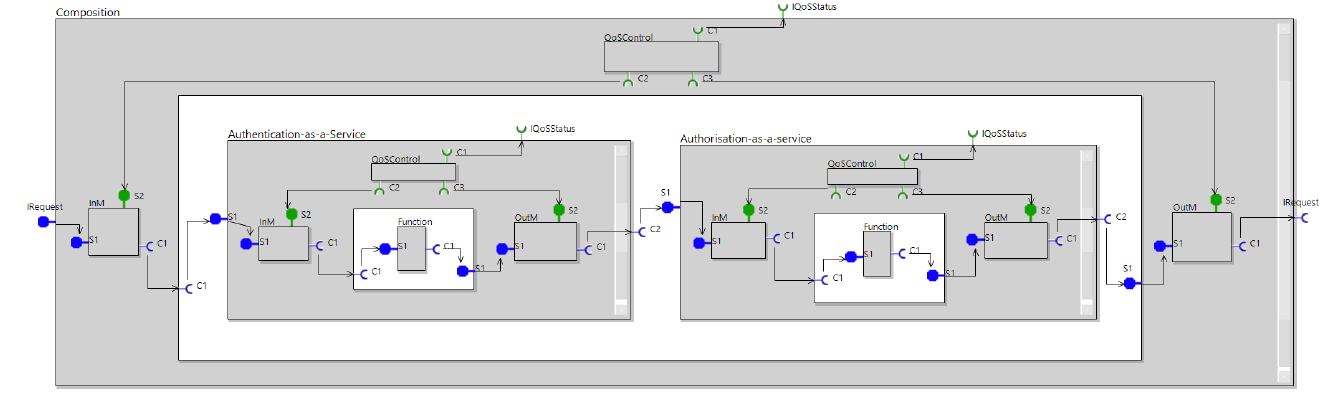
Figure 5. Example of composition